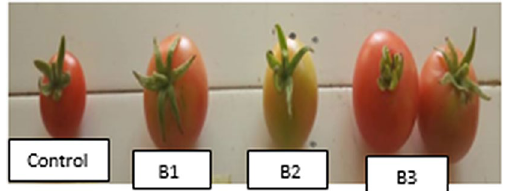
Figure 9. Different sizes of tomato fruits harvested at maturity.